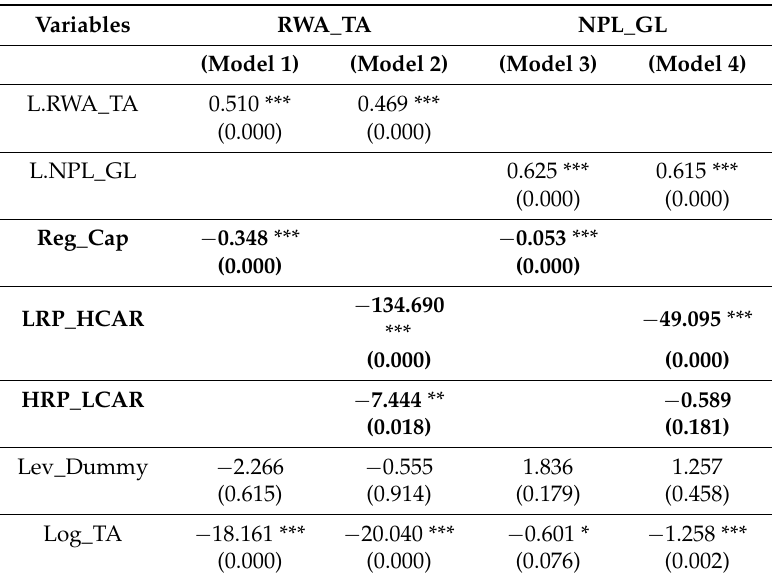
Table 7. Robustness tests: outlier